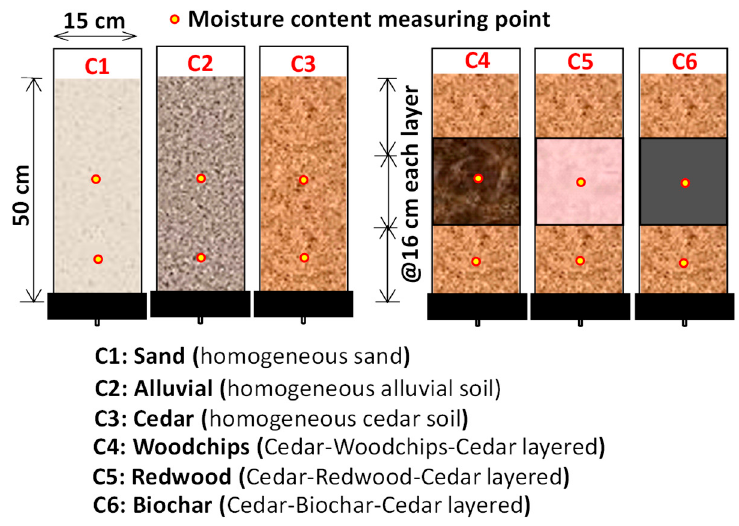
Figure 1. Experimental Column Setup.